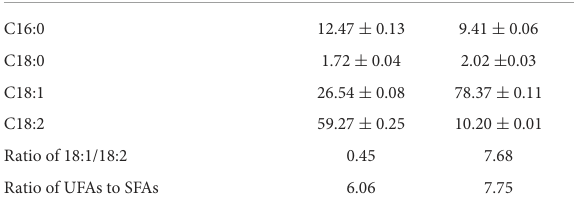
TABLE 2 Fatty acid composition of dietary